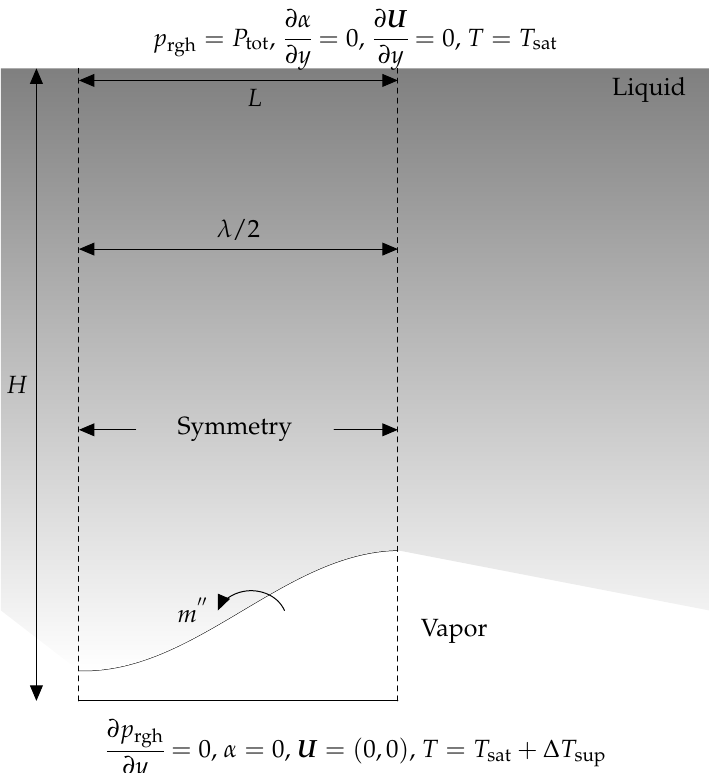
Figure 11. The diagram depicts the 2D film boiling scenario’s geometry and boundary conditions. Between the liquid’s surface and the vapor is a sinusoidal vapor layer. The liquid is at its saturation temperature, but the surface temperature is greater than it. The phase change happens at the liquid– vapor interface, and the bubbles of generated vapor depart the vapor film